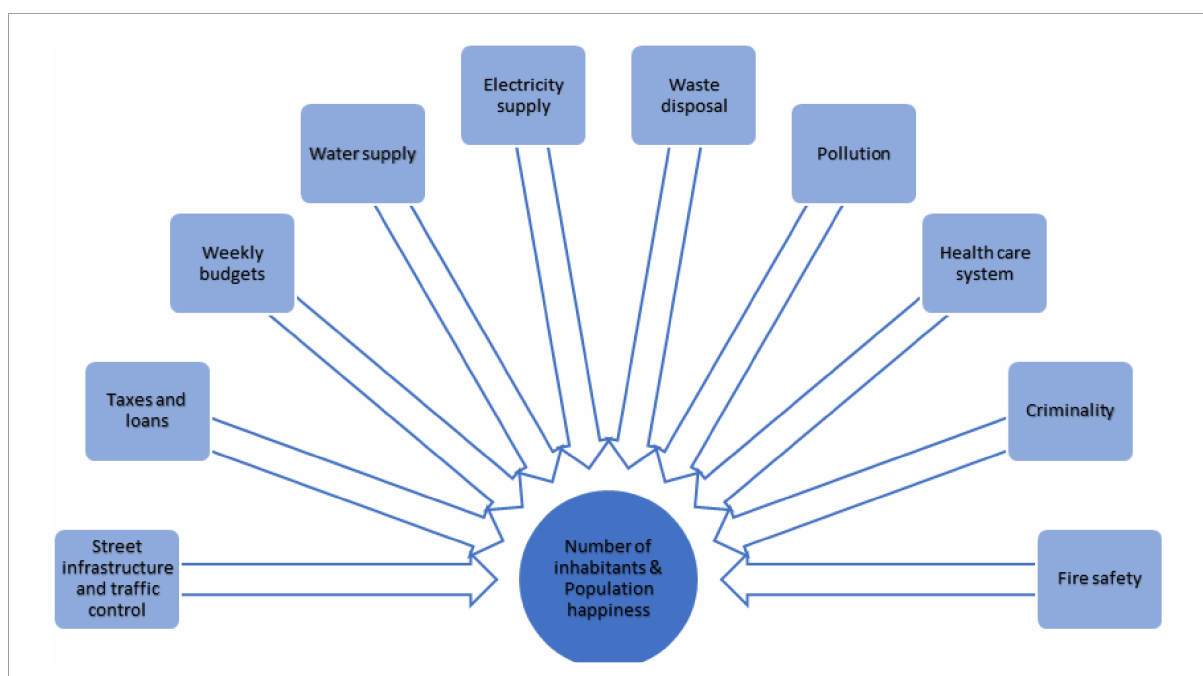
FIGURE1 Exemplary model of some (not all) factors that influence the number of inhabitants and the general happiness of the population in Cities: Skylines (CSL). The number of related variables illustrates the complexity, connectivity, and polytely in the simulated